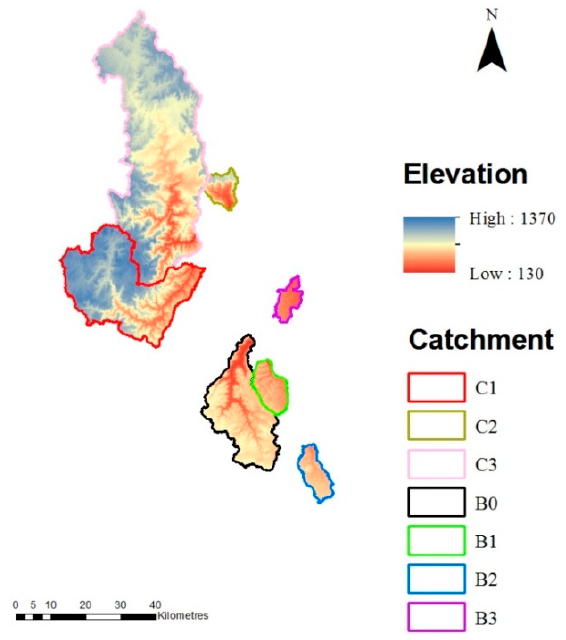
Figure 3. Elevation maps of studied catchments. Abbreviations: C = Control; B = Burnt.